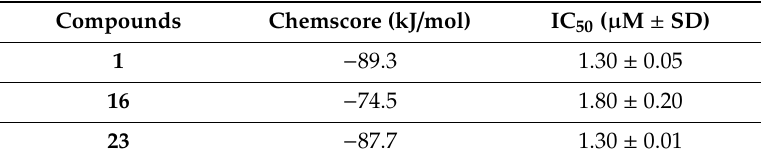
Table 2. Chemscore value for active compounds 1 , 16 , and 23 .